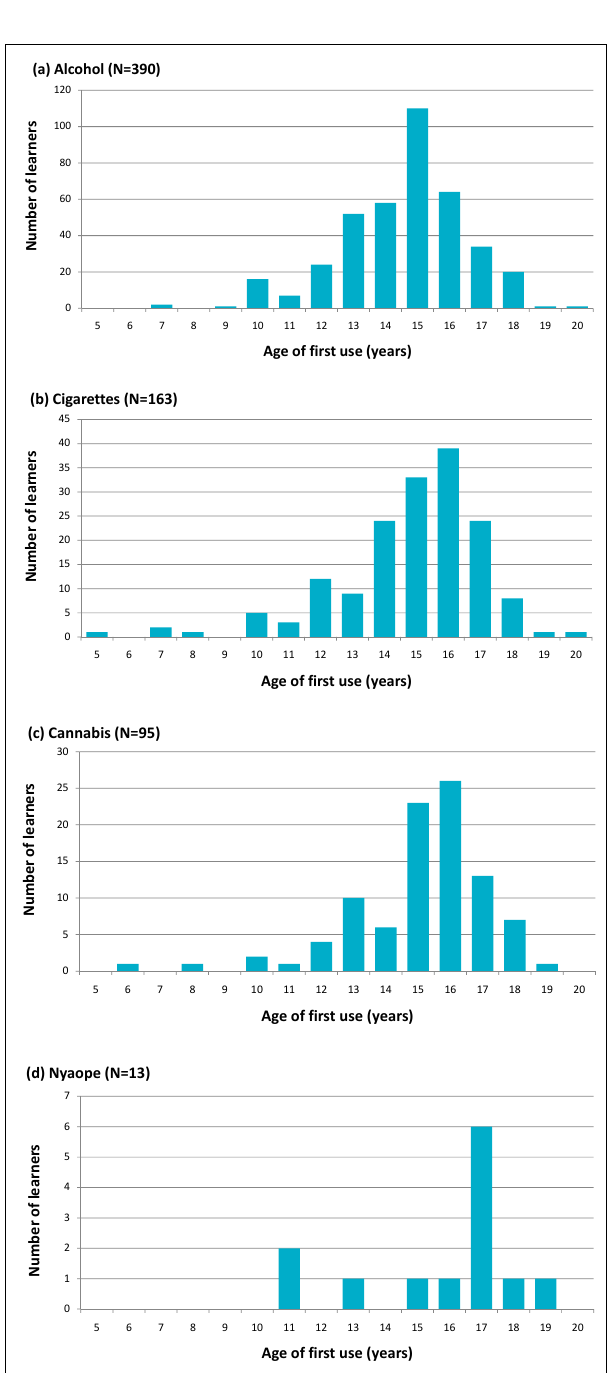
Fig. 1. Distribution of age of initiation of alcohol, cigarettes, cannabis and nyaope use among study participants.